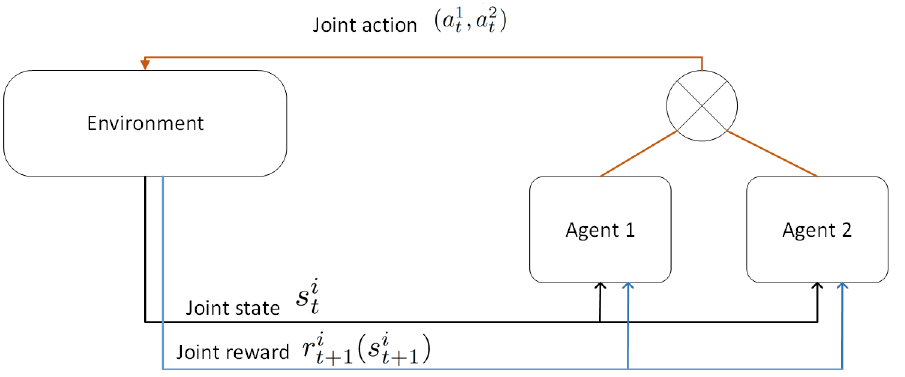
Figure 8. Architecture of MADRL concurrent